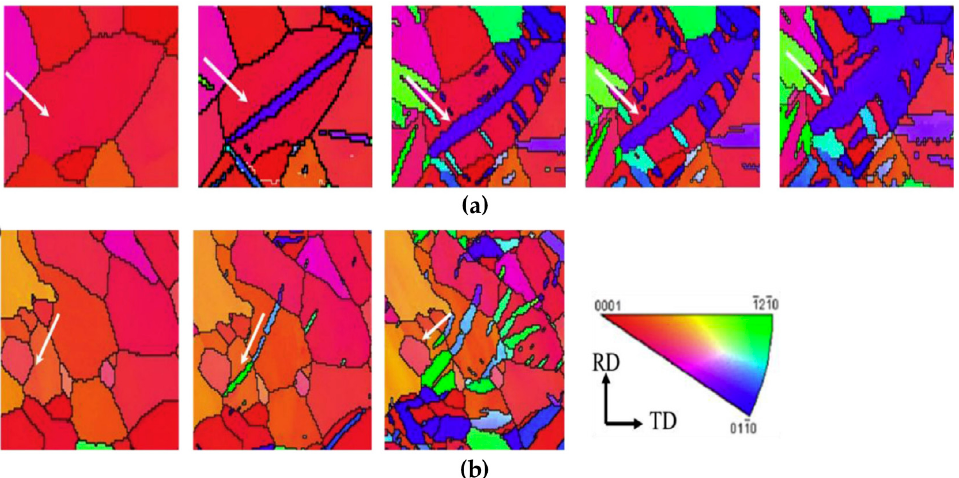
Figure 25. The process of twin transmission investigated by in-situ SEM mechanical testing with compressions strains of ( a ) 0, 1.6%, 3.1%, 4.2%, 5.4% and ( b ) 0%, 1%, 2%, respectively. (Reprinted from Reference [151], with permission from Elsevier).